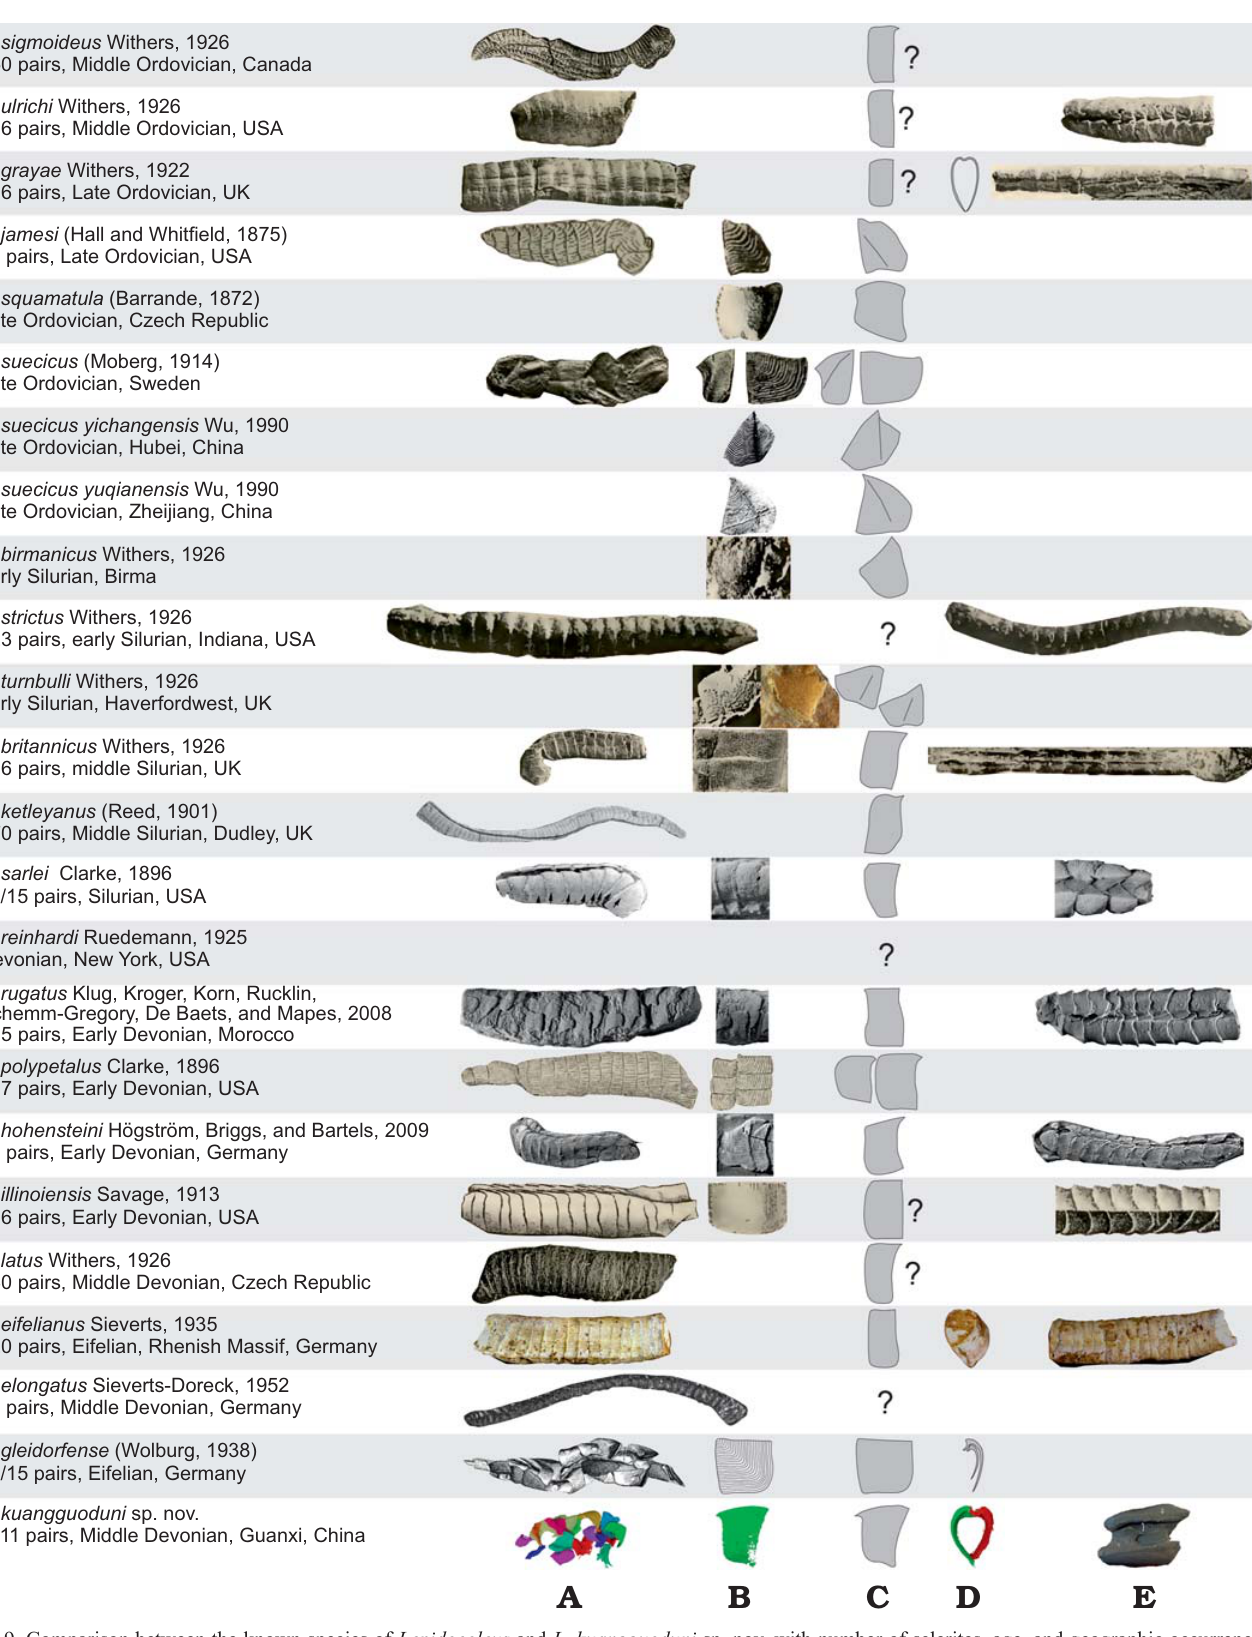
Fig. 9. Comparison between the known species of Lepidocoleus and L. kuangguoduni sp. nov. with number of sclerites, age, and geographic occurrence indicated; lateral ( A ) and dorsal ( E ) views of the fossils, images of sclerites ( B ), outlines of sclerites ( C ), cross sections, to show the proportions of the dorsal depression ( D